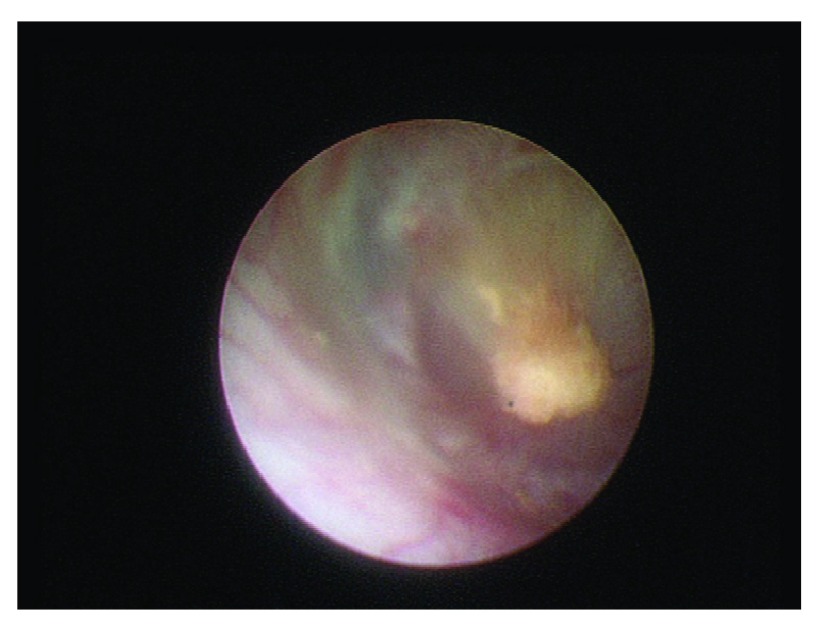
Renal papilla with high-grade calcifications in a patient with idiopathic calcium oxalate urolithiasis.